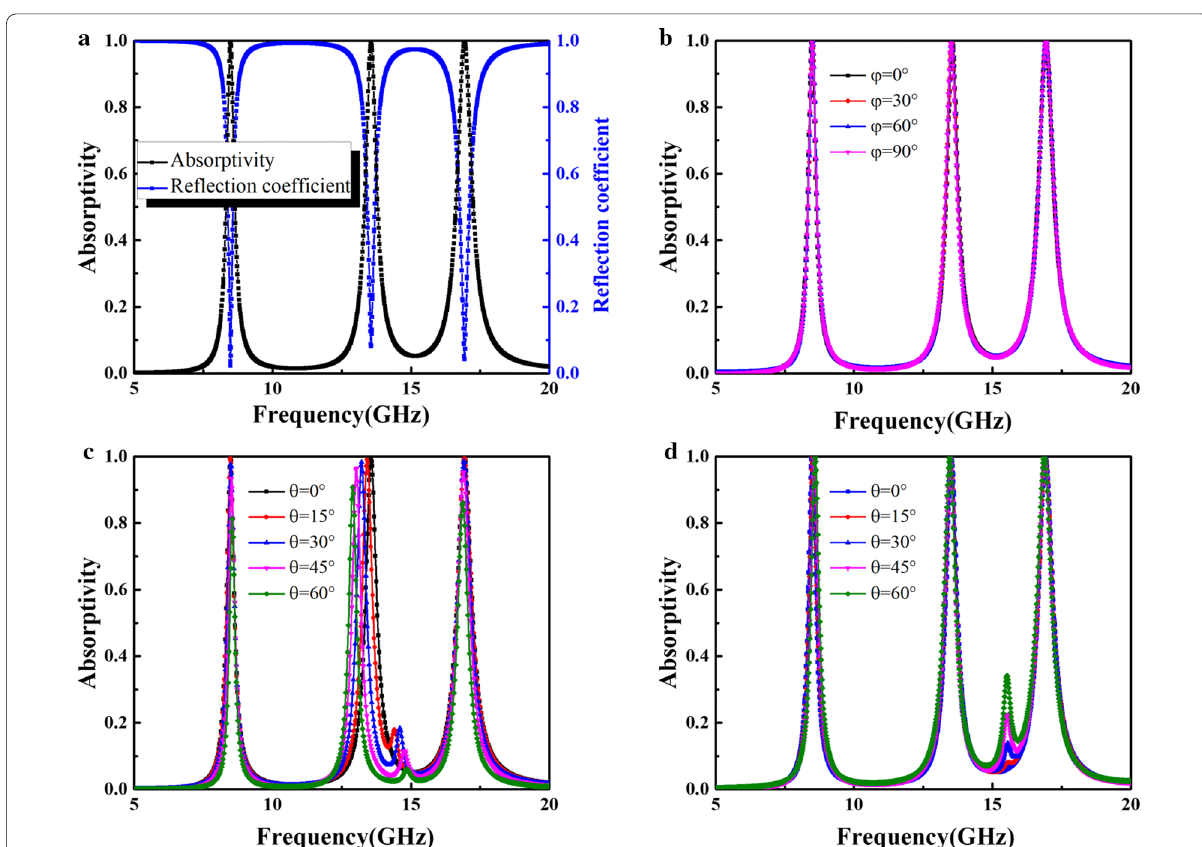
Fig. 2 a Simulated absorption and reflection spectra at normal incidence. b Absorption spectrum for different polarization angles φ . Absorption for different θ values for c TE and d TM